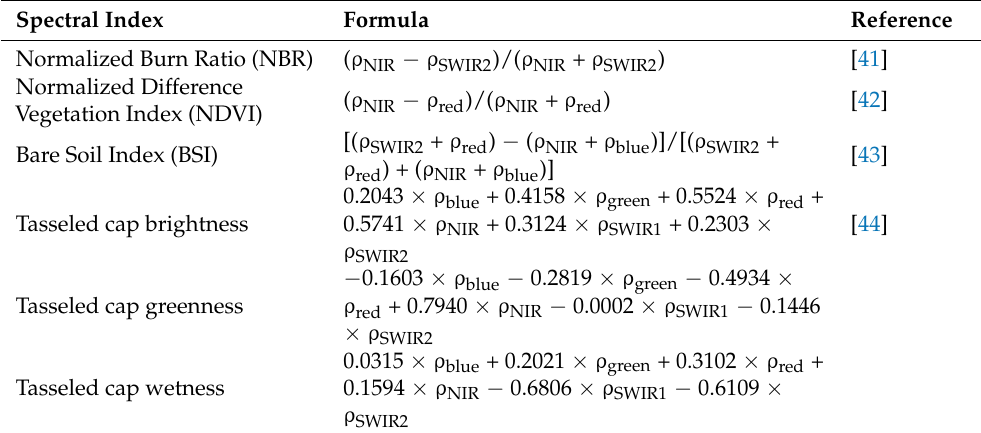
Table 2. Spectral index formulation and associated